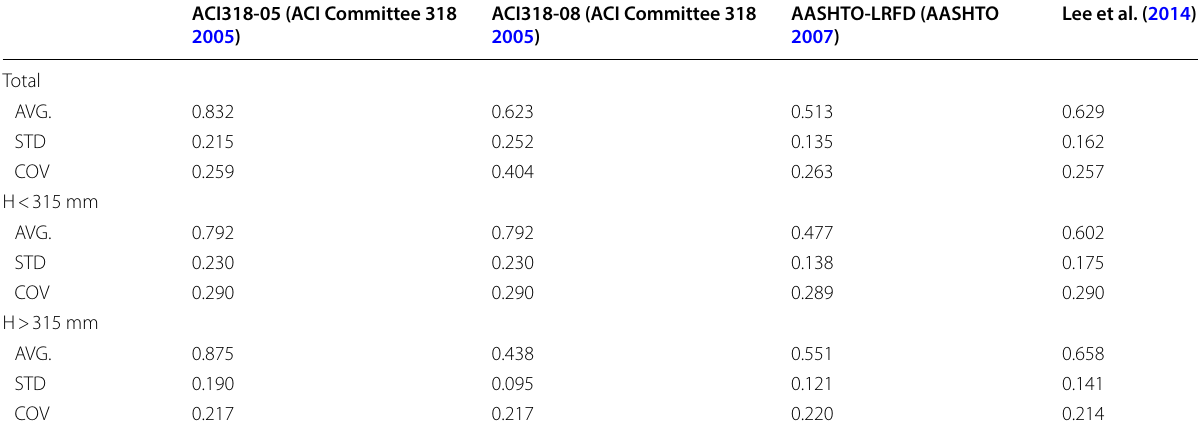
Table 3 Evaluation of web‑shear capacity estimation approaches.